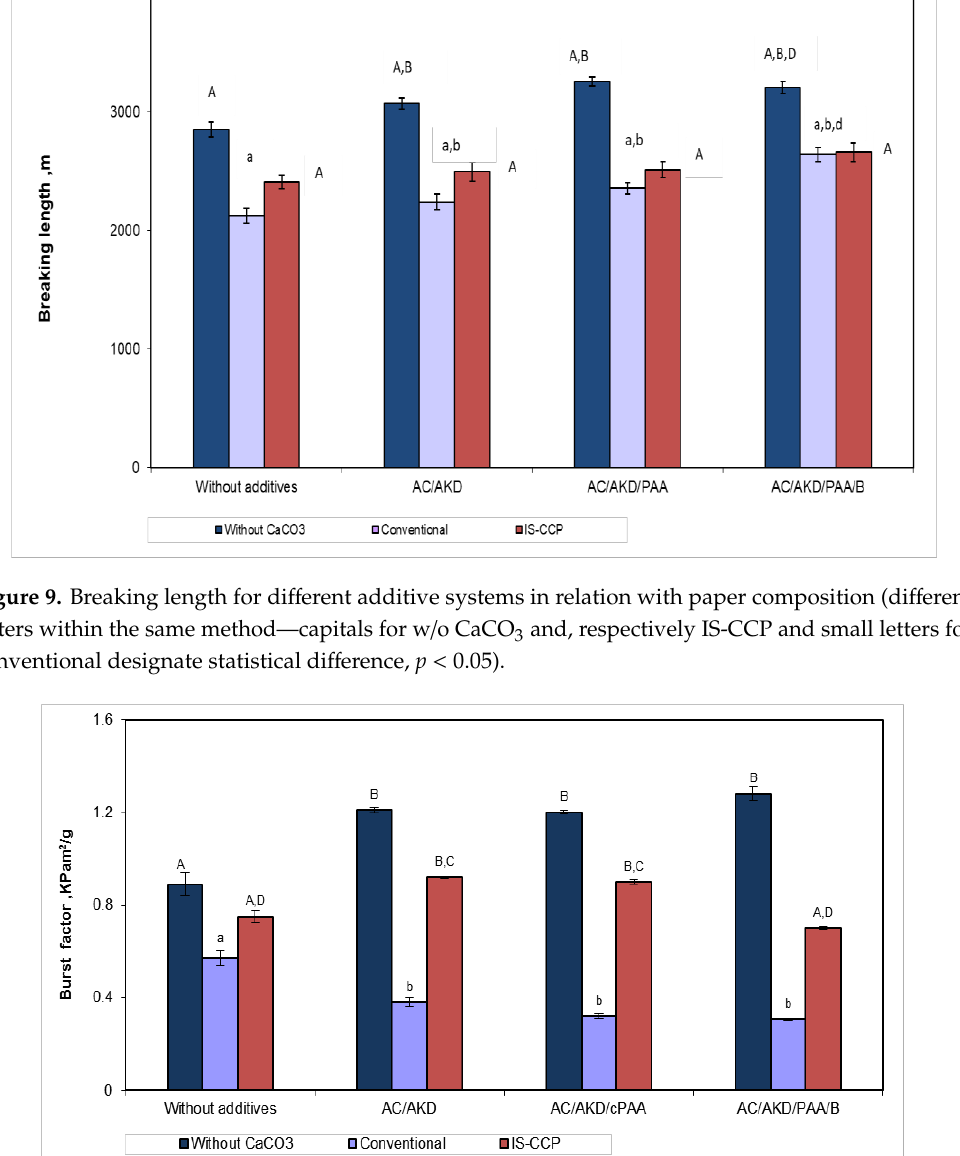
Figure 10. Burst factor for various additive systems in relation with paper composition (different letters within the same method—capitals for w/o CaCO 3 and, respectively IS-CCP and small letters for conventional designate statistical difference, p < 0.05).